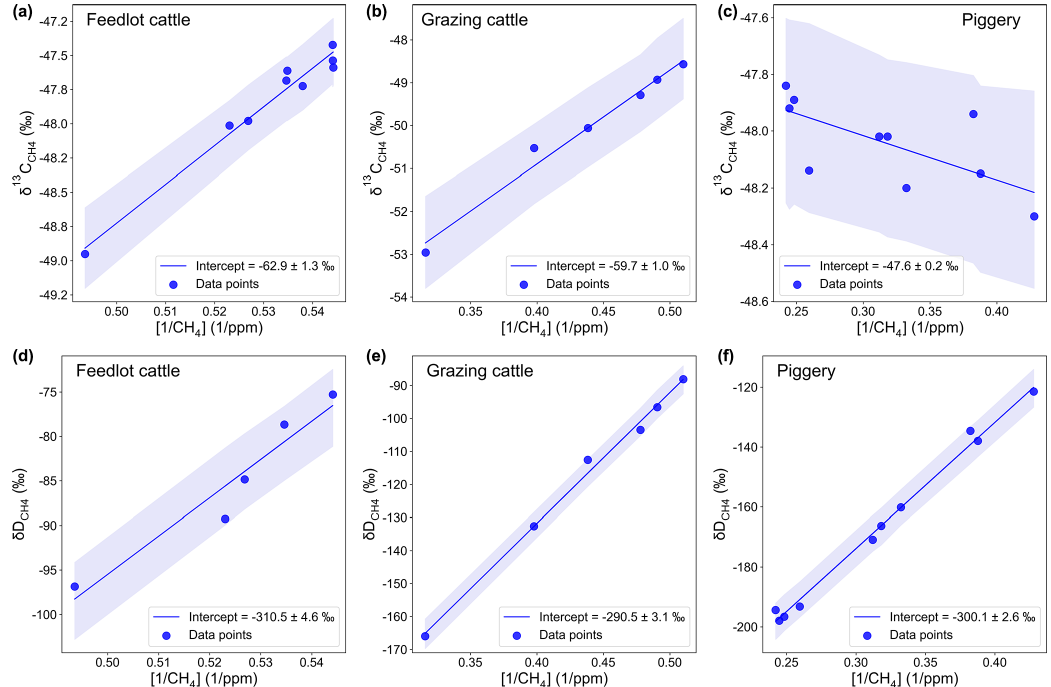
Figure A5. Keeling plots of all data from agricultural sources analysed using Bayesian linear regression. Upper panels show the results for δ 13 C and lower panels show the results for δ